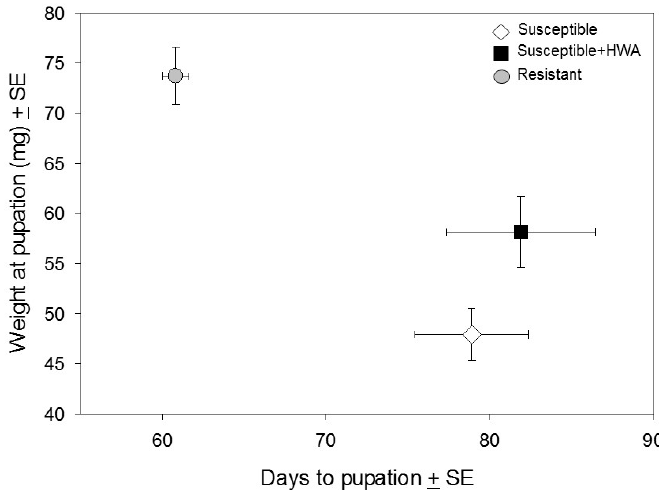
Figure 2. Relationship between days to pupation (x-axis) and pupal weight (y-axis) of L. fiscellaria larvae fed one of three different Tsuga foliage types. Susceptible = white diamonds; Susceptible + HWA = black squares; Resistant = gray circles. N = 16 for each sampling point.